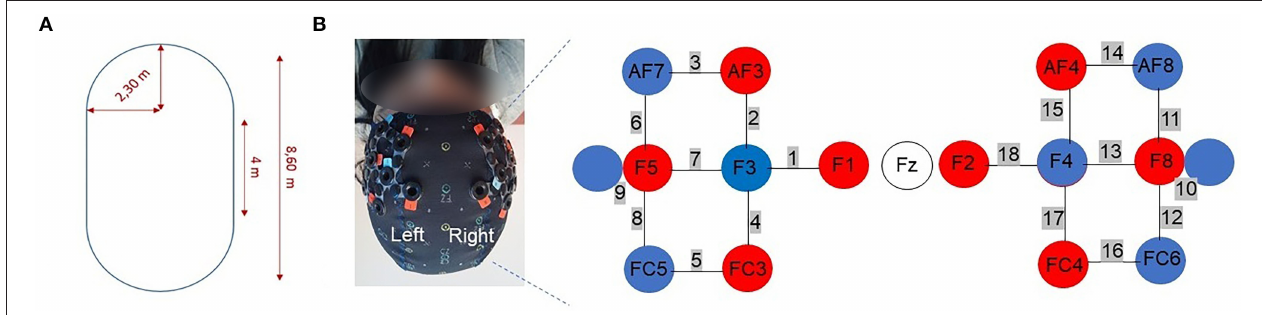
FIGURE 1 | (A) Walking path configuration. (B) Optodes configuration. The right panels show the optodes with respect to the Fz locations of the international 10-10 system. Red circles represent the sources and blue circles represent the detectors. The numbers in gray represent the channels. Channels 9 and 10 represent the short separation